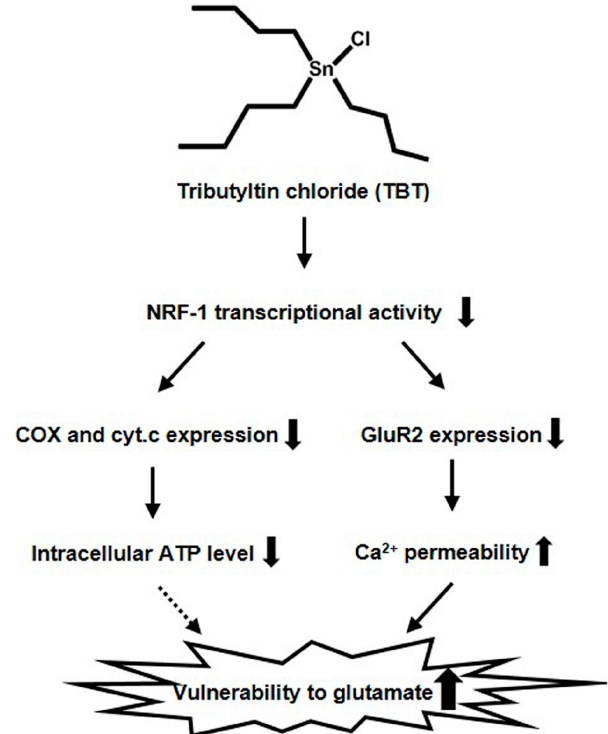
Figure 6. Schematic representation of the proposed mechanism by which TBT induces neurotoxicity via NRF-1 inhibition in primary cortical neurons. 20 nM TBT inhibits the transcriptional activity of NRF-1, and subsequently decreases the expression of downstream genes, including GluR2 and mitochondrial related genes (cyt.c, COX4, and COX6c). The decrease in expression of GluR2 and the mitochondrial related genes results in an increase in neuronal Ca 2+ permeability and a decrease in the intracellular ATP level, respectively, which ultimately enhances neuronal vulnerability to glutamate excitotoxicity. Solid arrows indicate the identified pathways. Dashed arrow indicates the hypothetical pathway. Solid lines thick arrows (up) indicate the increase. Solid lines thick arrows (down) indicate the decrease.